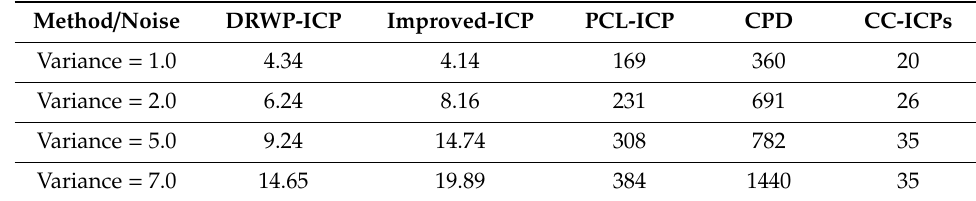
Table 4. Alignment times (seconds).